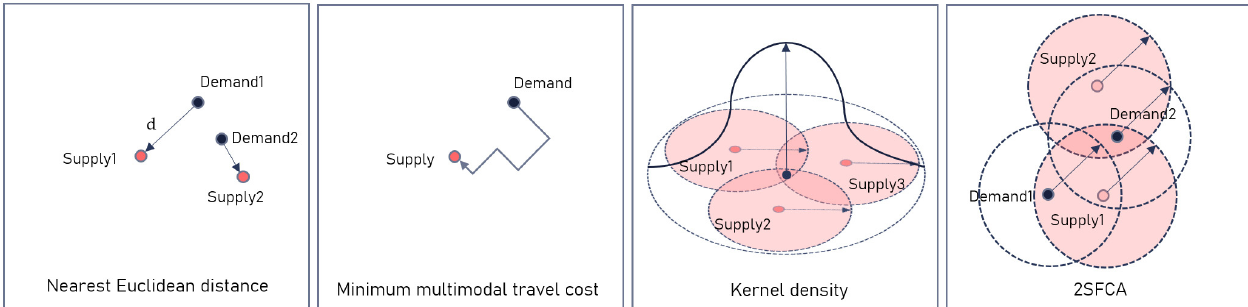
Figure 4. Multimodal accessibilities of public